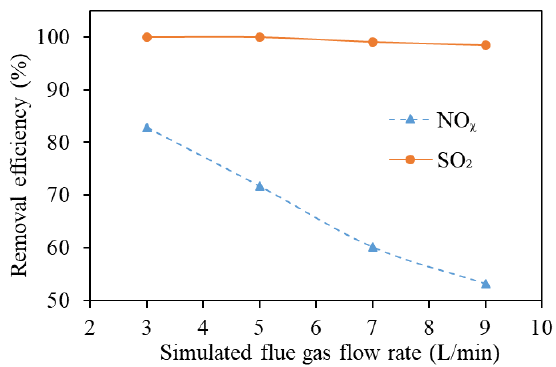
Figure 11. Effects of simulated flue gas flow rate on desulfurization and denitration efficiency levels (operating conditions: discharge power in DBD reactor = 19.5 W, spray density = 7.6 m 3 /(m 2 · h), scrub-